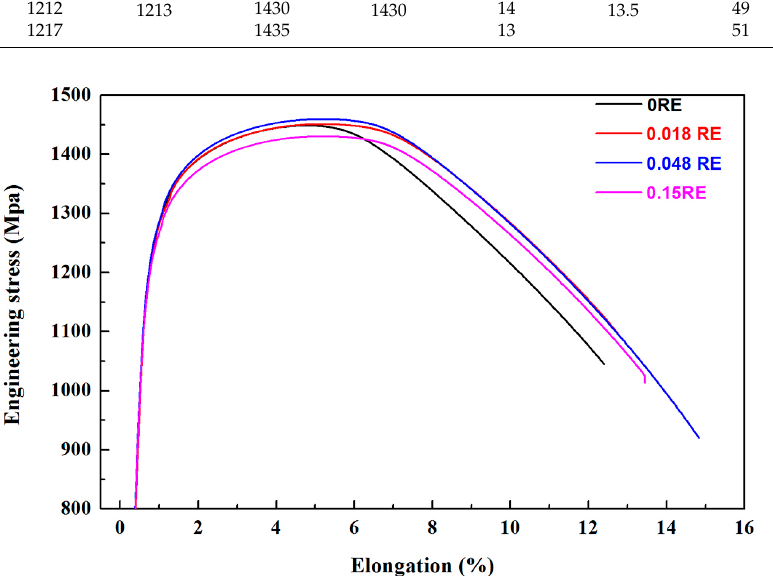
Figure 8. The representative engineering tensile stress-strain curves in response to different additions of RE.